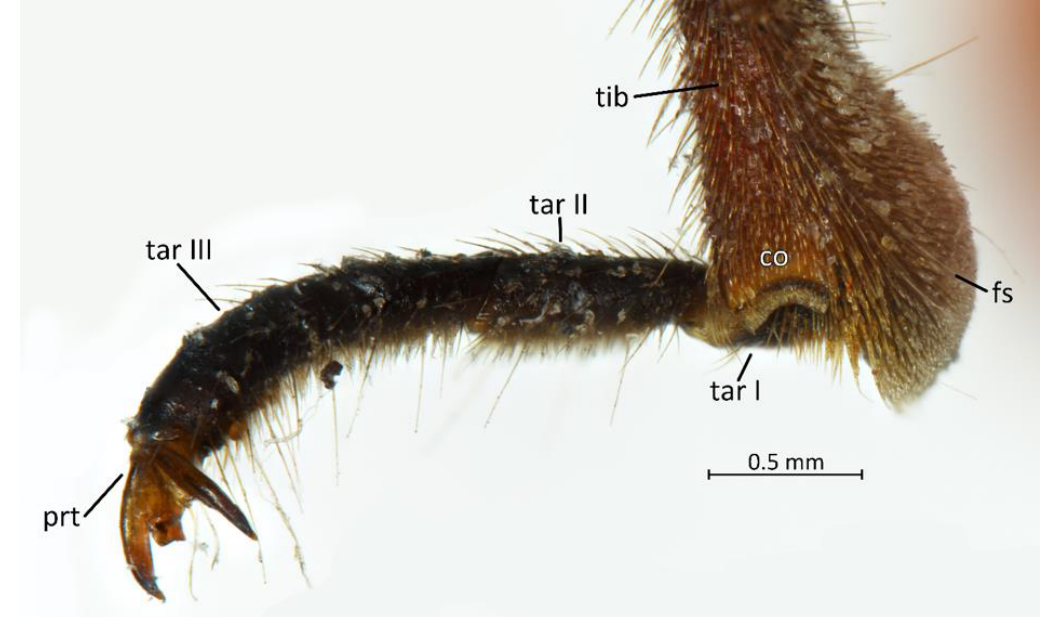
Figure 22. The tibiae with tarsi and pretarsi of the foreleg with fossula spongiosa of Phonoctonus caesar Haglund, 1895, lateral view. co — comb; fs — fossula spongiosa; prt — pretarsus; tar I — the first tarsomere; tar II — the second tarsomere; tar III — the third tarsomere; tib — tibia.